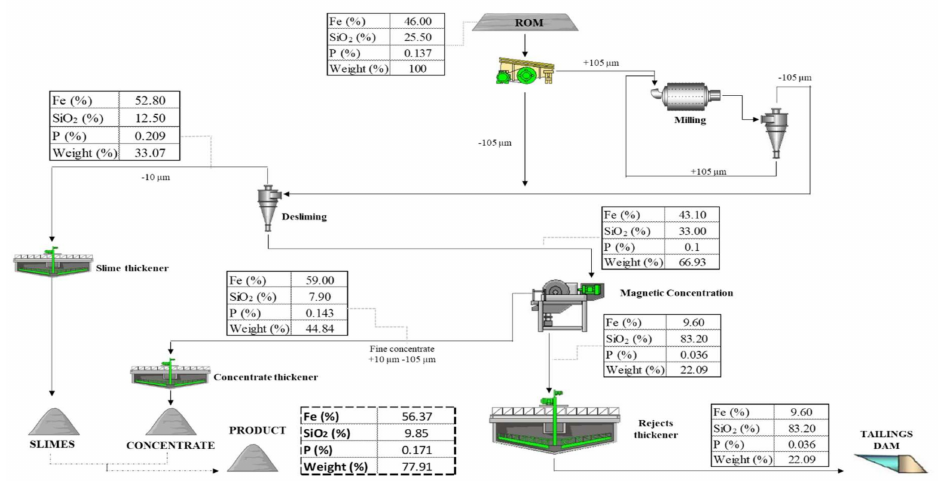
Figure 8. Proposed flowsheet of the magnetic concentration of the amphibolitic itabirite (open